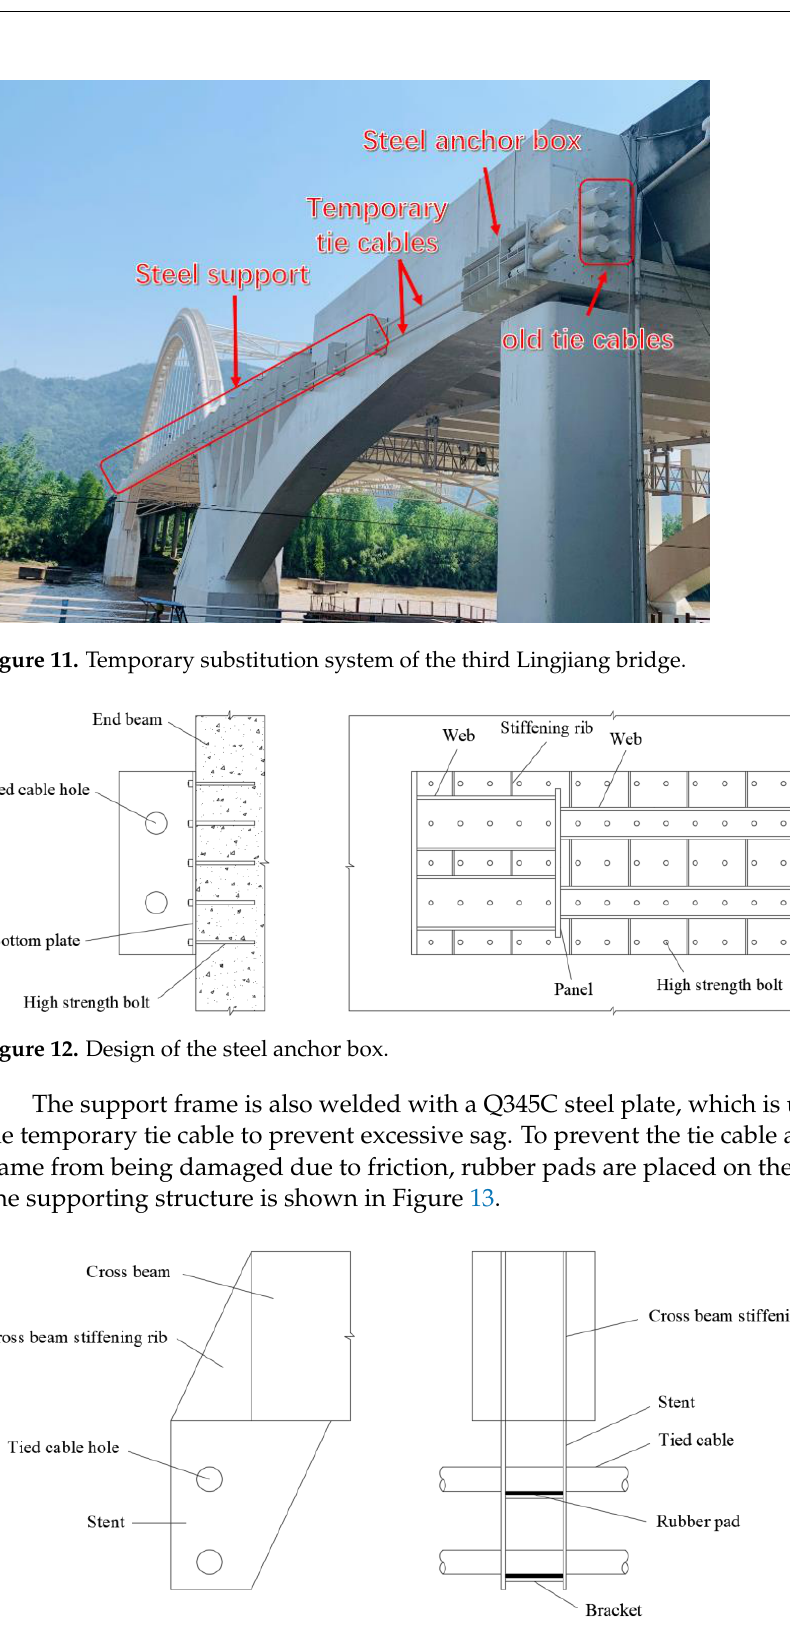
Figure 13. Design of the support frame.